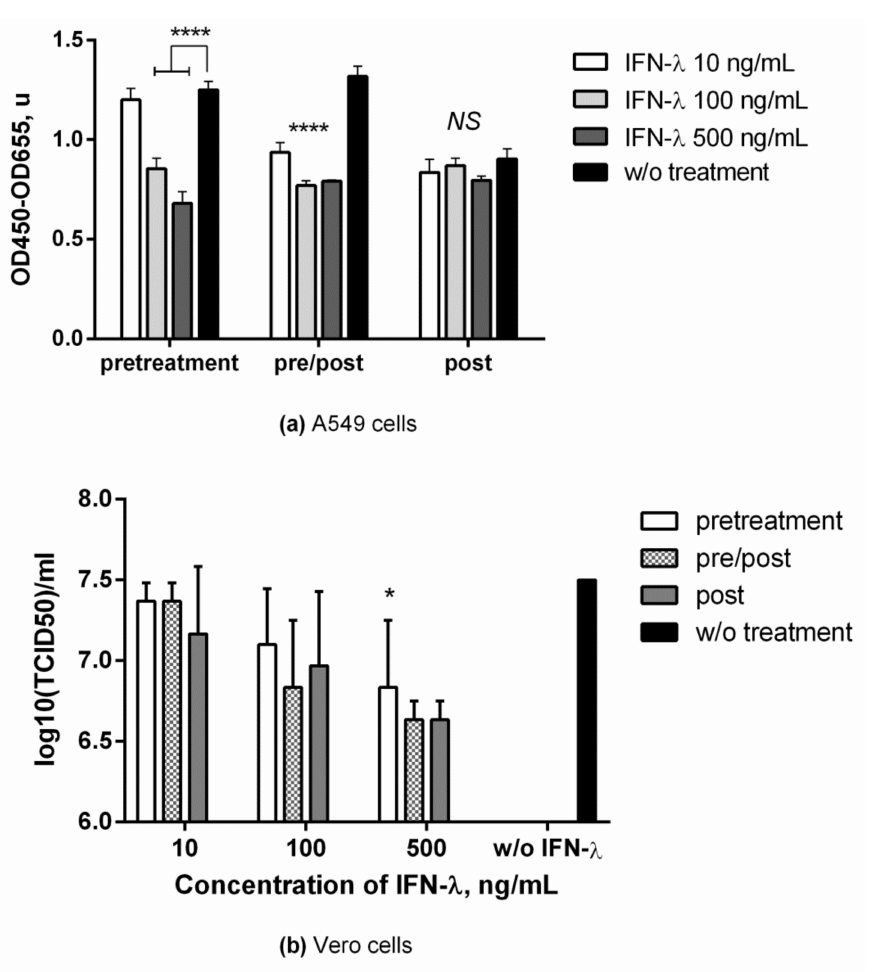
Figure 1. Inhibition of influenza A replication in different IFN- λ 1 treatment regimes . ( a ) A549 cells were infected by A/California/07/09 (H1N1pdm09) without trypsin. Viral antigen was mea- sured at 24 hpi by In-Cell ELISA with anti-NP antibodies; ( b ) Vero cells were infected by A/PR/8/34 (H1N1) with subsequent addition of TPCK-treated trypsin. Viral titers were determined at 72 hpi. p -value significance levels were obtained by comparing groups using the ordinary one-way ANOVA analysis ( a ) or Kruskal-Wallis test ( b ), followed by a pairwise Dunnett’s multiple comparisons test: ****—Adjusted p value < 0.0001; *—< 0.05; NS—no significant difference. Data are represented as mean ±